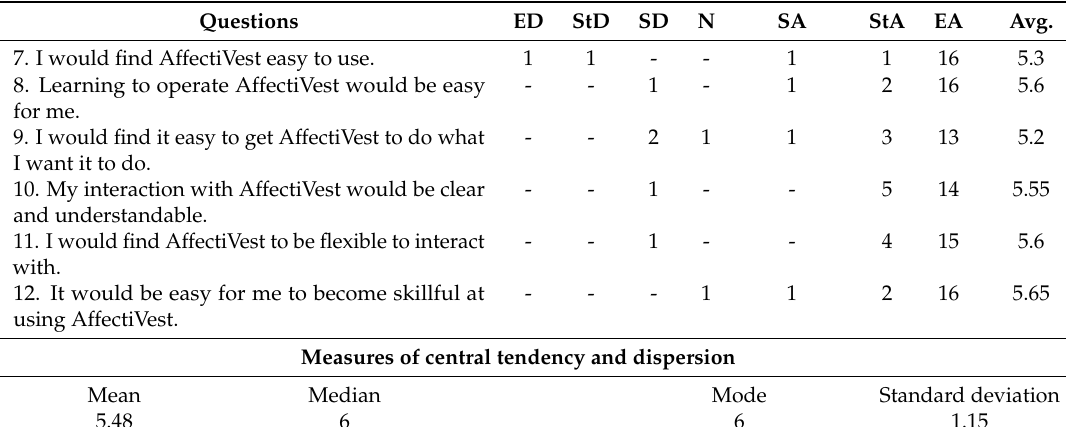
Table 3. Participants’ perceived ease of